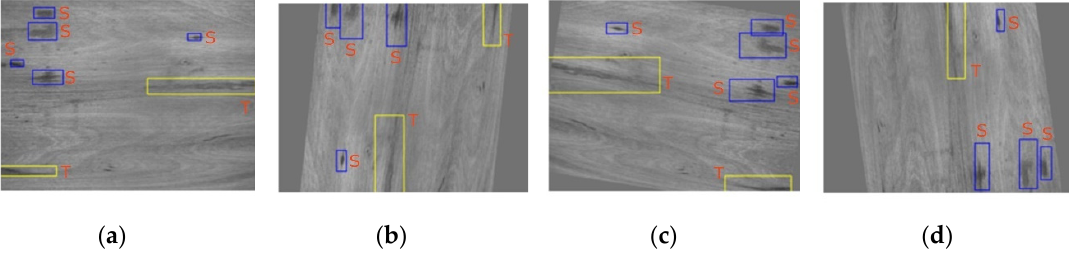
Figure 5. An image of wood veneer labeled using VoTT. Green is used to label the branch (B) defects. Blue is used to label the split (S) defects. Yellow is used to label the stain (T) defects.